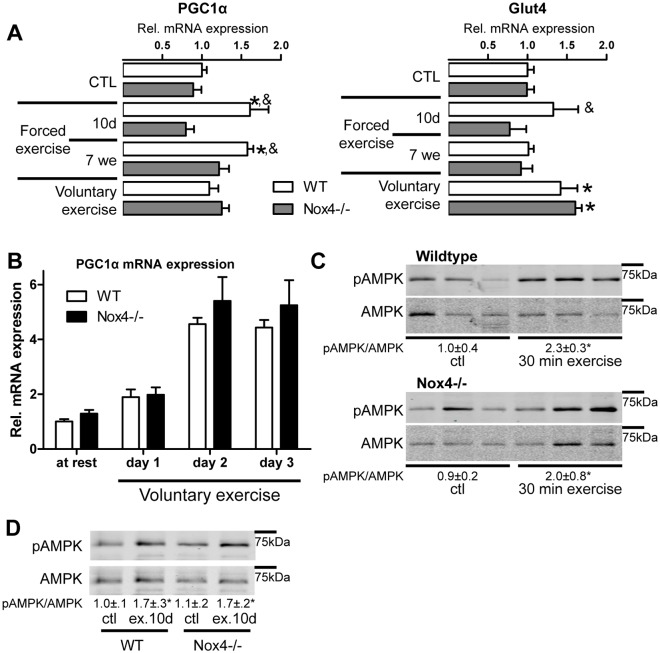
Exercise-induced switch in muscle energy metabolism is Nox4 independent.(A) Quantitative PCR for the genes indicated after 10 days and 7 weeks of repeated forced or 4 weeks of voluntary exercise. (B) Timeline of a quantitative PCR for PGC1α in musculus soleus tissue with voluntary exercise. mean±SEM (n>5). *p <0.05 (ctl vs. exercise); &p<0.05 (WT vs. Nox4-/-) (C&D) Western blot of musculus soleus tissue after (C) 30 of min single or (D) 10 day of repeated forced exercise. Numbers below the blots indicate the ratio of pAMPK and AMPK revealed by densitometry, mean±SEM (n>3). *p <0.05 (ctl vs. Ex.)